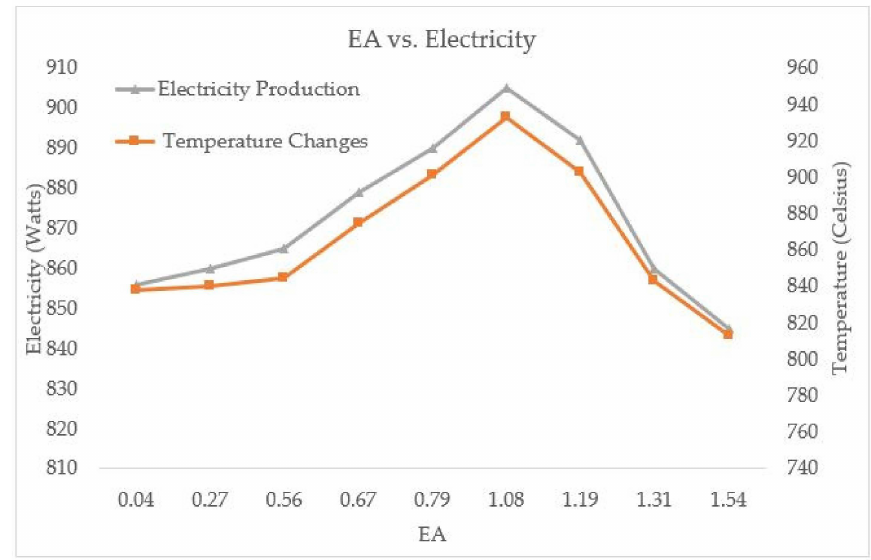
Figure 4. E ff ects of EA ratio on electricity outputs and chamber